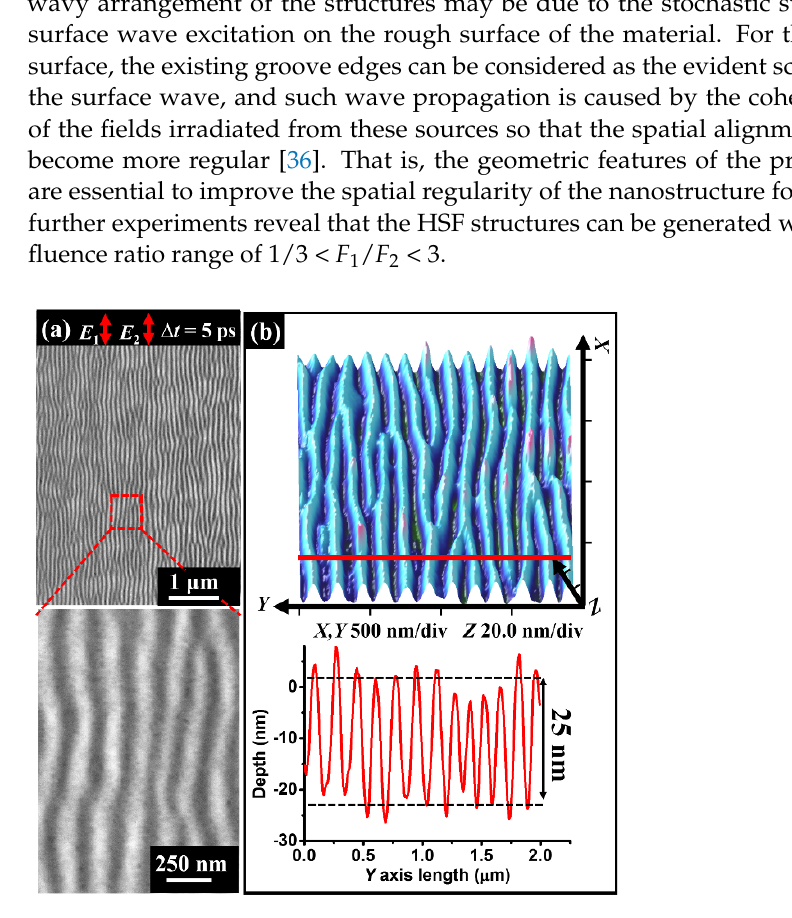
Figure 8. ( a , b ) SEM and AFM images of LIPSSs on the flat surface of Fe-based metallic glass. Bottom illustration in ( b ) shows the measured cross-section curve for a small portion (Red line) of the structure formation on material surface.